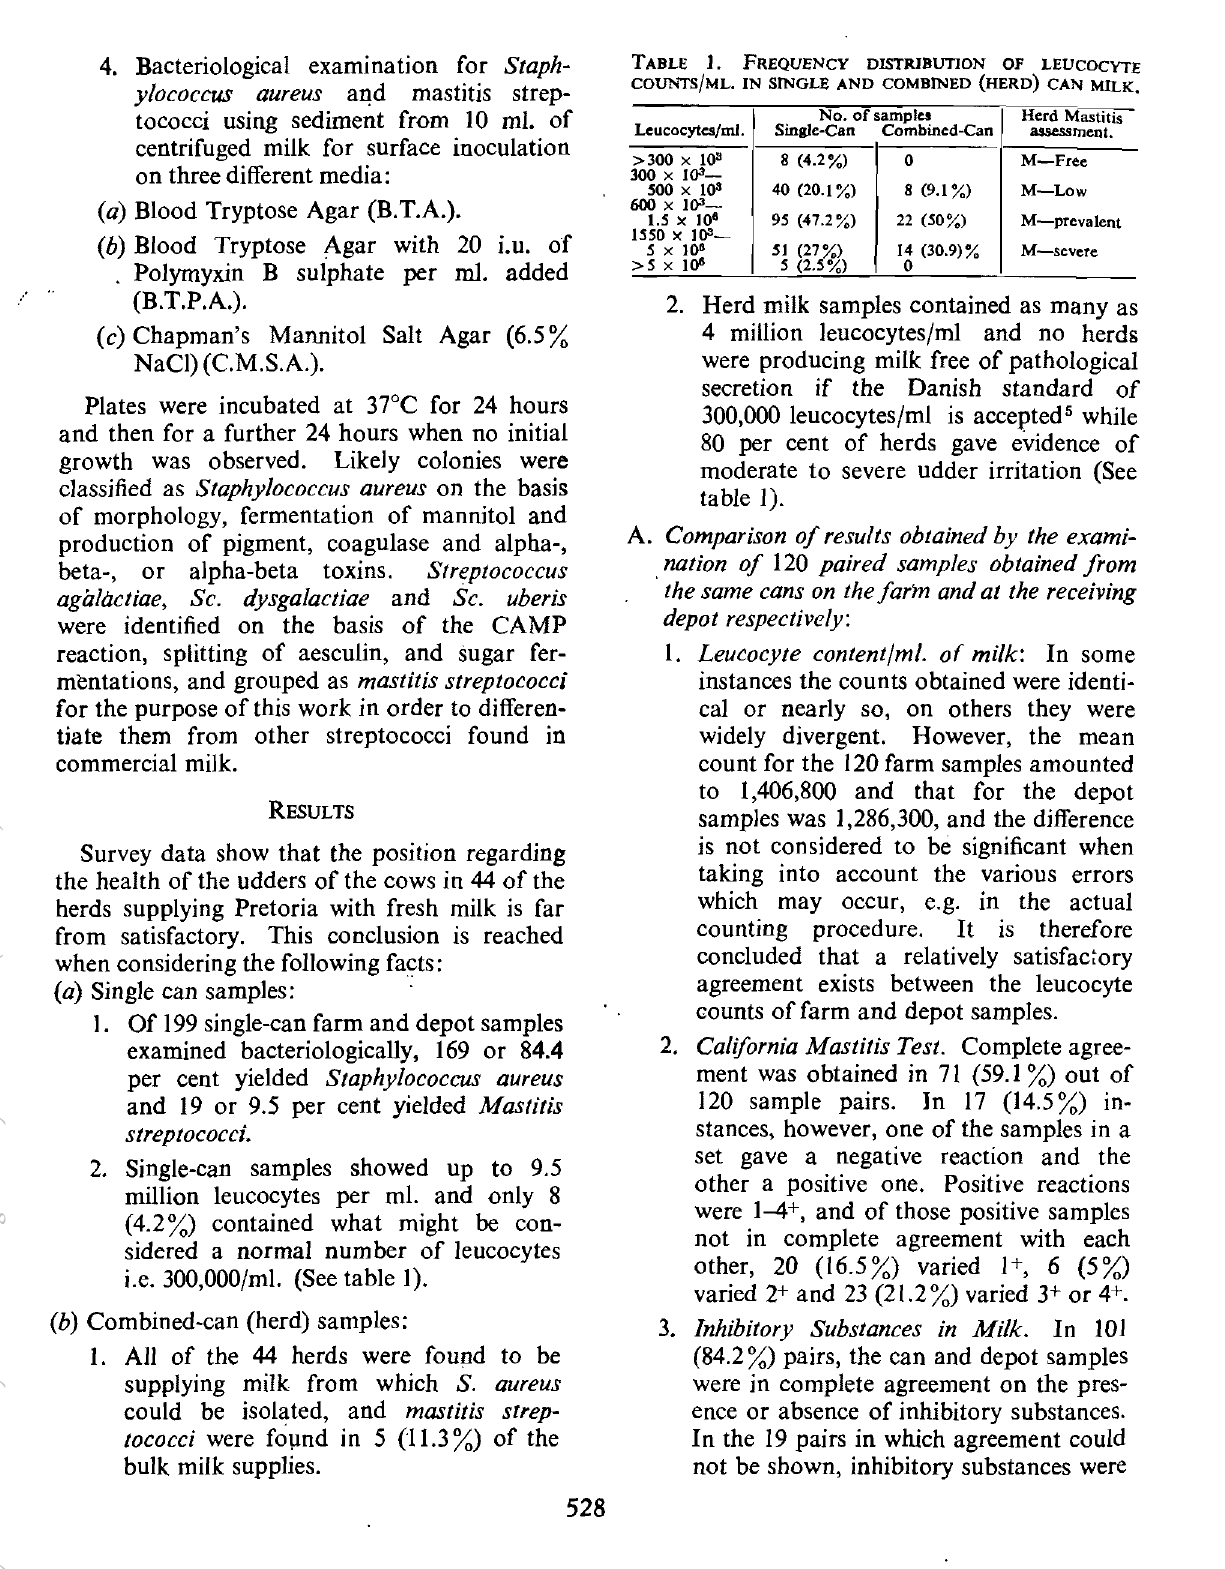
TABLE 1. FREQUENCY DISTRIBUTION OF LEUCOCYTE COUNTS/ML. IN SINGLE AND COMBINED (HERD) CAN MILK. Leucocytes/ml.